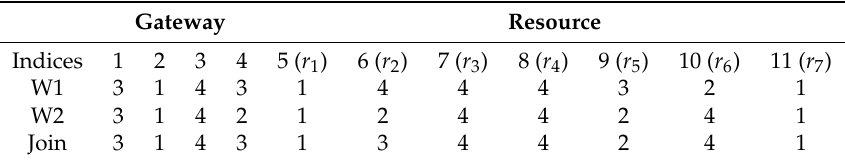
Table 6. An example of join